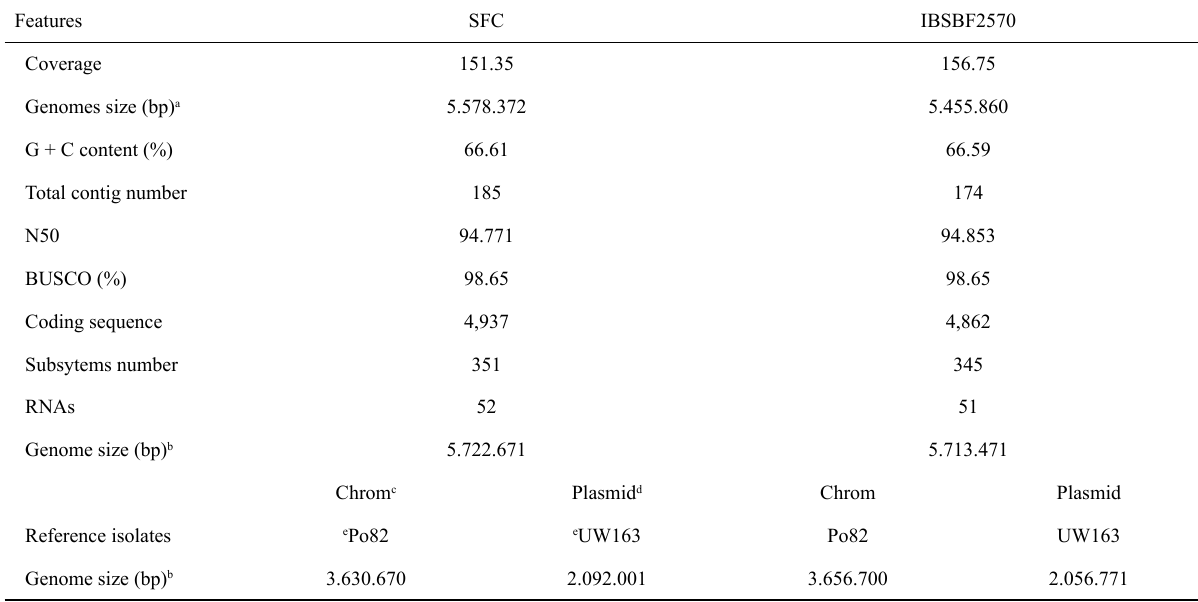
Table 1 – Genome characteristics of isolates SFC and IBSBF2570 of Ralstonia solanacearum causing Sergipe facies disease.